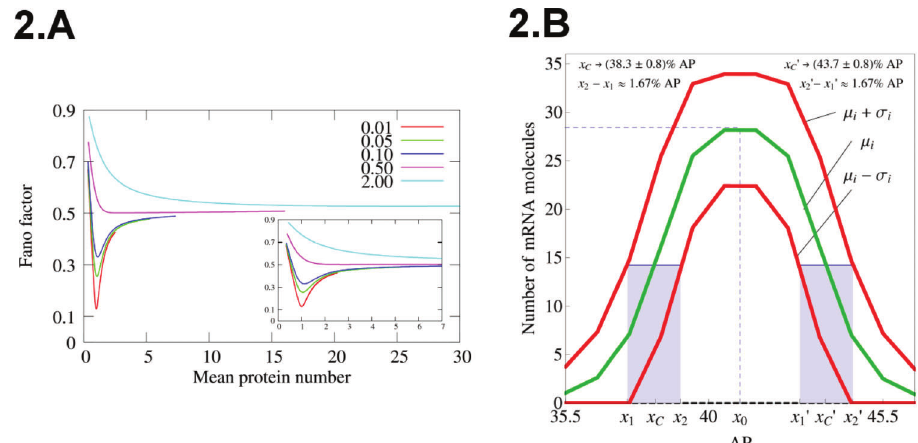
Figure 2 - ( A ) Fano factor versus average protein number for the self-repressing gene. The value of a is fixed as 500. The values of b s are indicated within the graph, while we varied the value of z 0 . (B) Spatial profile of mRNA average amounts along the AP axis of a D. melanogaster embryo. We also included the fluctuation in the positions of the borders of the peak expression along with the standard deviation of n at each nucleus along the AP axis. The positions of the borders are computed at the point where n h i is half of its maximal value at the position 41.5% of the embryo